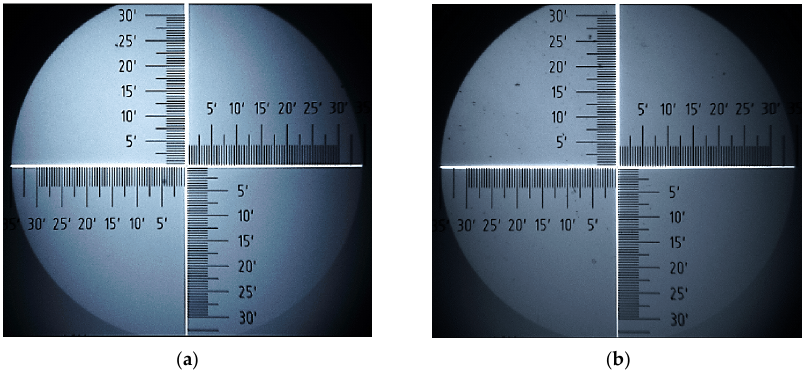
Figure 8. P3HT before ( a ) and after annealing ( b ).